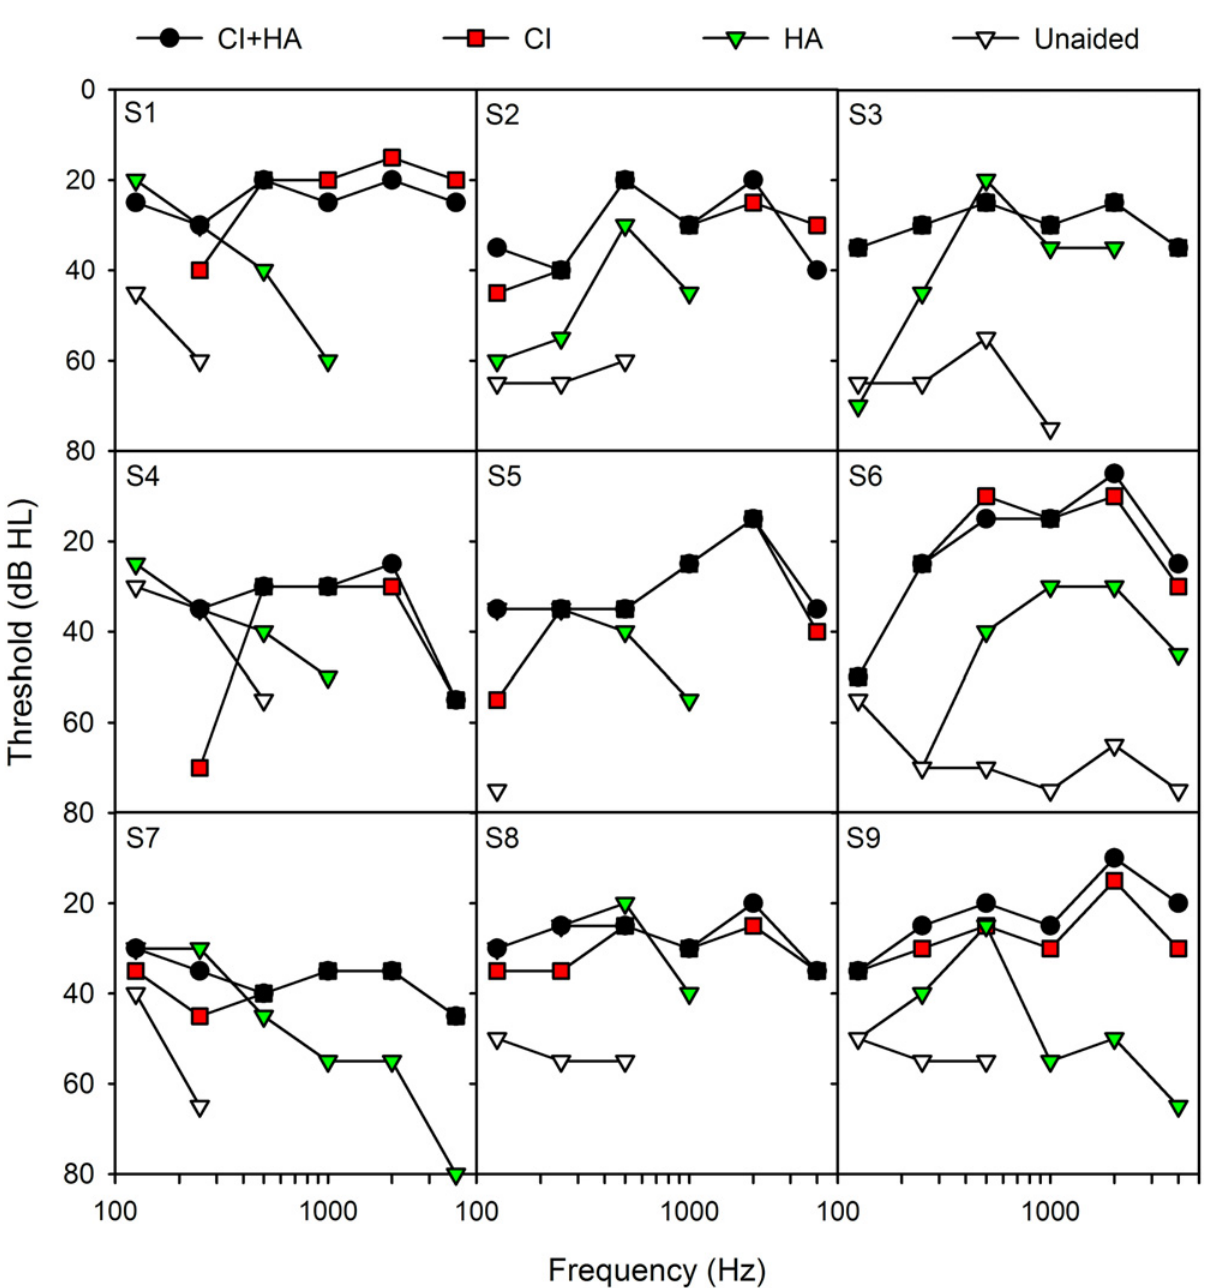
Fig 1. Audiometric thresholds for each subject for different hearing devices. CI+HA (black circles), CI (red boxes), HA (green triangles), and unaided (white triangles) thresholds are shown for each subject. Thresholds greater than 80 dB HL are not